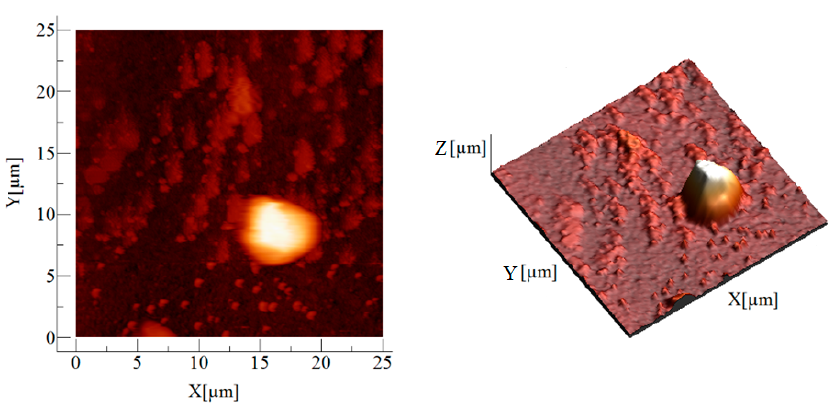
Figure 2. 2D and 3D image of the Am-L-GA sample on 25 µ m × 25 µ m area (Z = 1.9 µ m in the 3D representation).